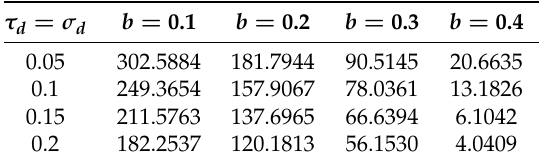
Table 2. Maximum allowable upper bounds σ of Example 1 for α = 0.0038.